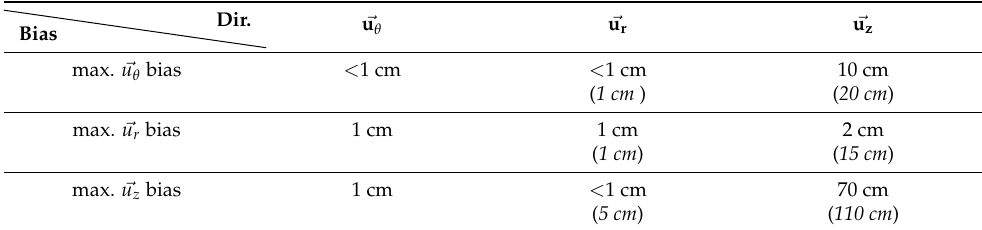
Table 2. Direction-dependent localization bias in the 3 directions (cylindrical coordinates), for a typical 1 m displacement. Each column corresponds to a different direction of displacement. Each line represents the localization bias amplitude along a certain direction, during the 1 m displacement. The values in italic correspond to field experiment localization bias